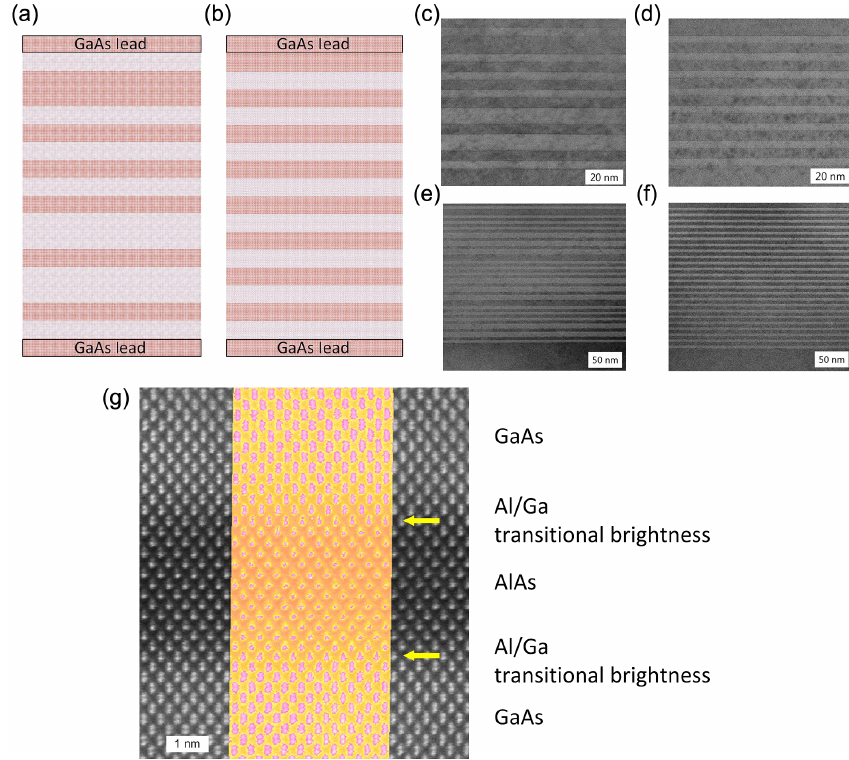
FIG. 2. Designed and fabricated SL samples. (a) Schematics of the global optimal GaAs/AlAs SL structure obtained by materials informatics (MI) from the candidate pool of 2 16 ð¼ 65536 Þ structures. Red and gray layers denote GaAs (0) and AlAs (1), respectively. Binary label is 1001010101101101 from the top to bottom with GaAs leads on the two ends. (b) Schematic of the reference periodic structure with a binary label of 0101010101010101. TEM images of the fabricated (c) optimal aperiodic and (d) reference periodic GaAs/AlAs SL structures, corresponding to the schematics in (a) and (b), respectively. To magnify the thermal conductivity difference between the optimal aperiodic and reference periodic structures, each structure is repeated for three times to obtain longer GaAs/AlAs SL structures, as shown in (e) and (f), respectively. (g) Atomistic-resolution TEM to identify the monolayer interfacial roughness denoted by the